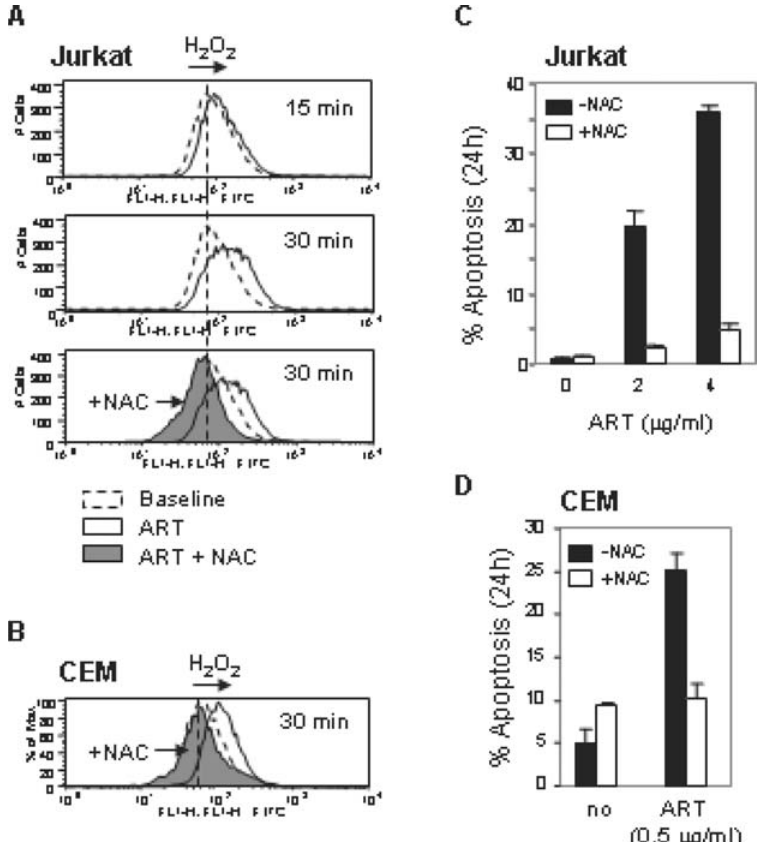
Figure 3. ROS mediate ART-induced apoptosis in leukemia cells. (A) Jurkat cells were treated with 4 m g/ml of ART for different times as indicated and the redox status was monitored by the oxidation-sensitive fluorescent dyes for H 2 O 2 . (B) CEM cells were treated with 0.5 m g/ml doses ART. After 30 min, the redox status was measured as in (A). (C) and (D) ART-induced apoptosis was blocked by the antioxidant NAC. Jurkat (C) and CEM (D) cells were treated with ART in the presence (15 mM) or absence of NAC for 24 h. Apoptotic cell death was analyzed by FSC/SSC in triplicates. Results are representative of four independent experiments.